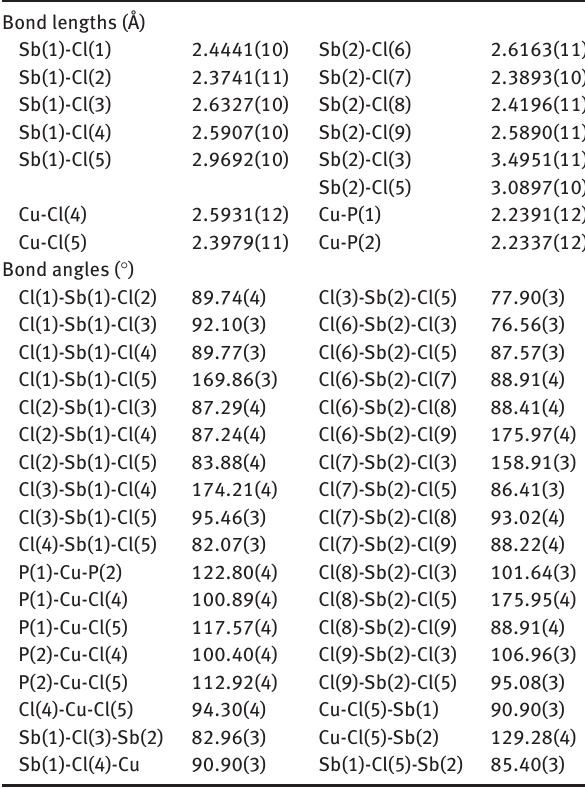
Table 1 Selected geometric data (Å, ° ) for 8